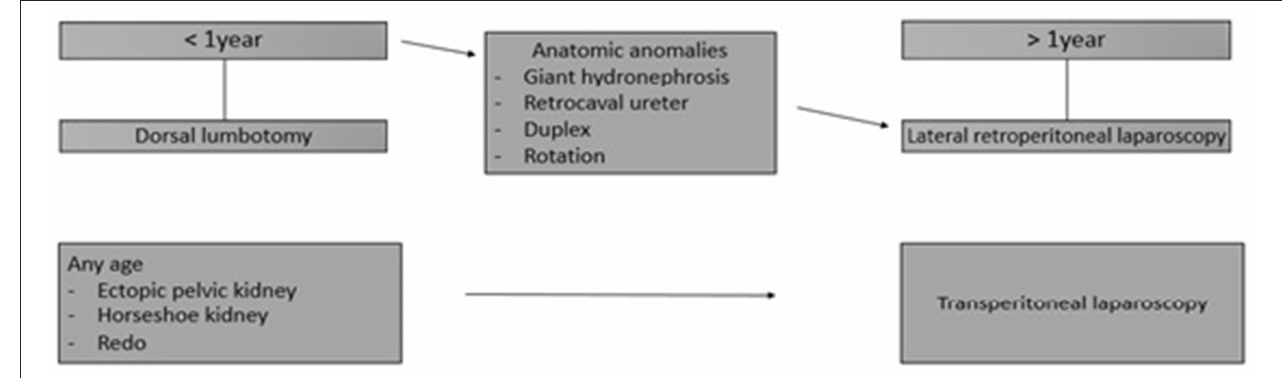
FIGURE 1 | Our strategy for UPJO management before 2012.